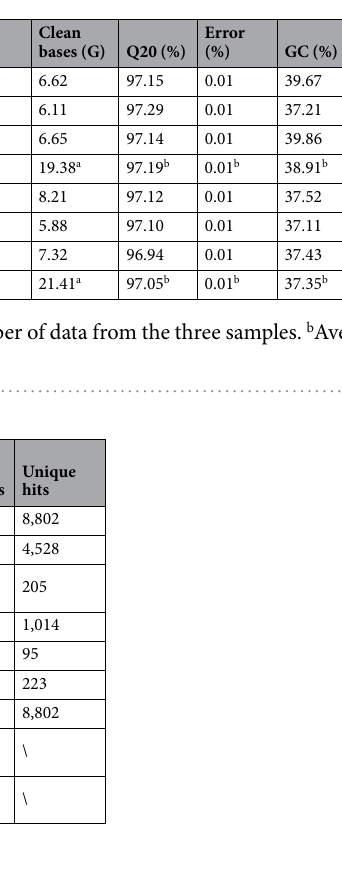
Figure 2. Phylogenetic analysis based on 16S rRNA and COI genes. The nucleotide sequences of 16S rRNA ( A ) and COI ( B ) genes of the Desmos Manus isolate were compared with those of the shrimp that were available in GenBank. Phylogenetic trees were generated by distance-based neighbor-joining method with 1,000 bootstrap replicates. The sequences marked with “ ● ” are from this study.